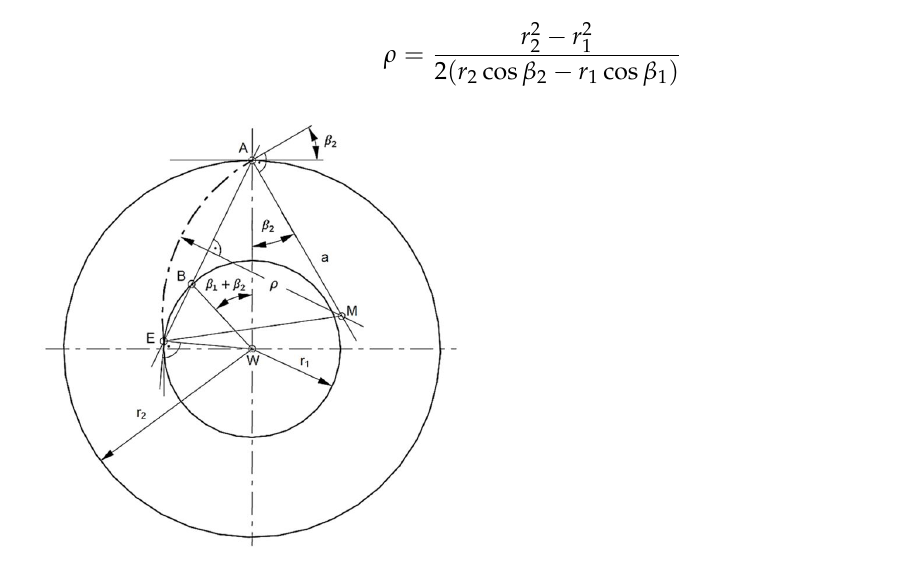
Figure 4. Single arc method for blade design [48].